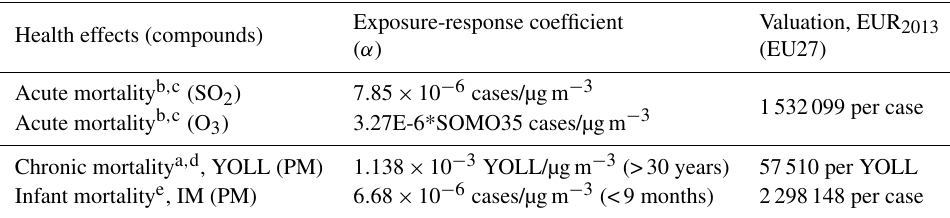
Table 2. Exposure-response functions (ERFs) used in EVA to calculate premature